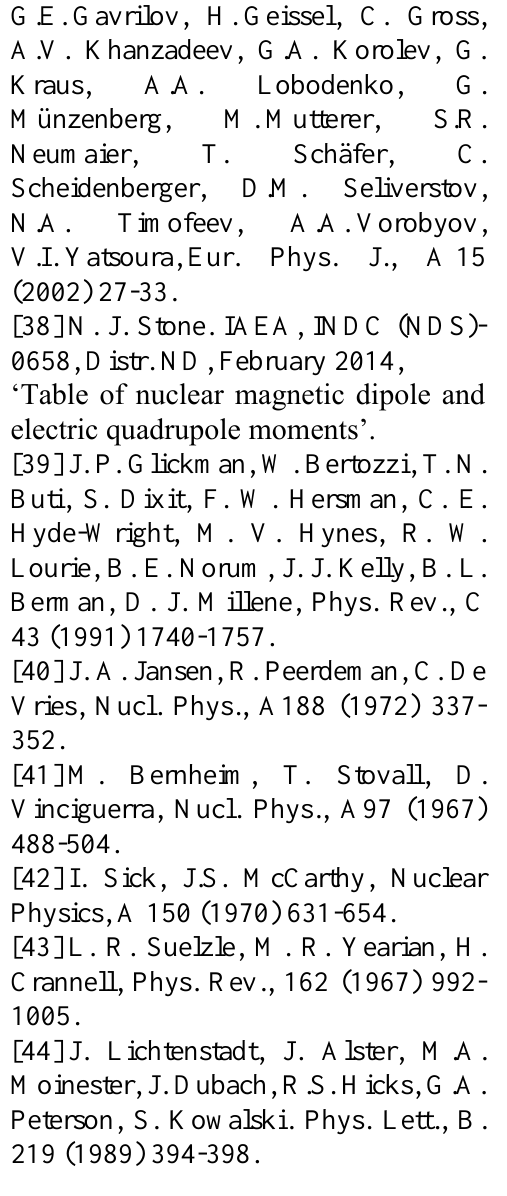
„Table of nuclear magnetic dipole